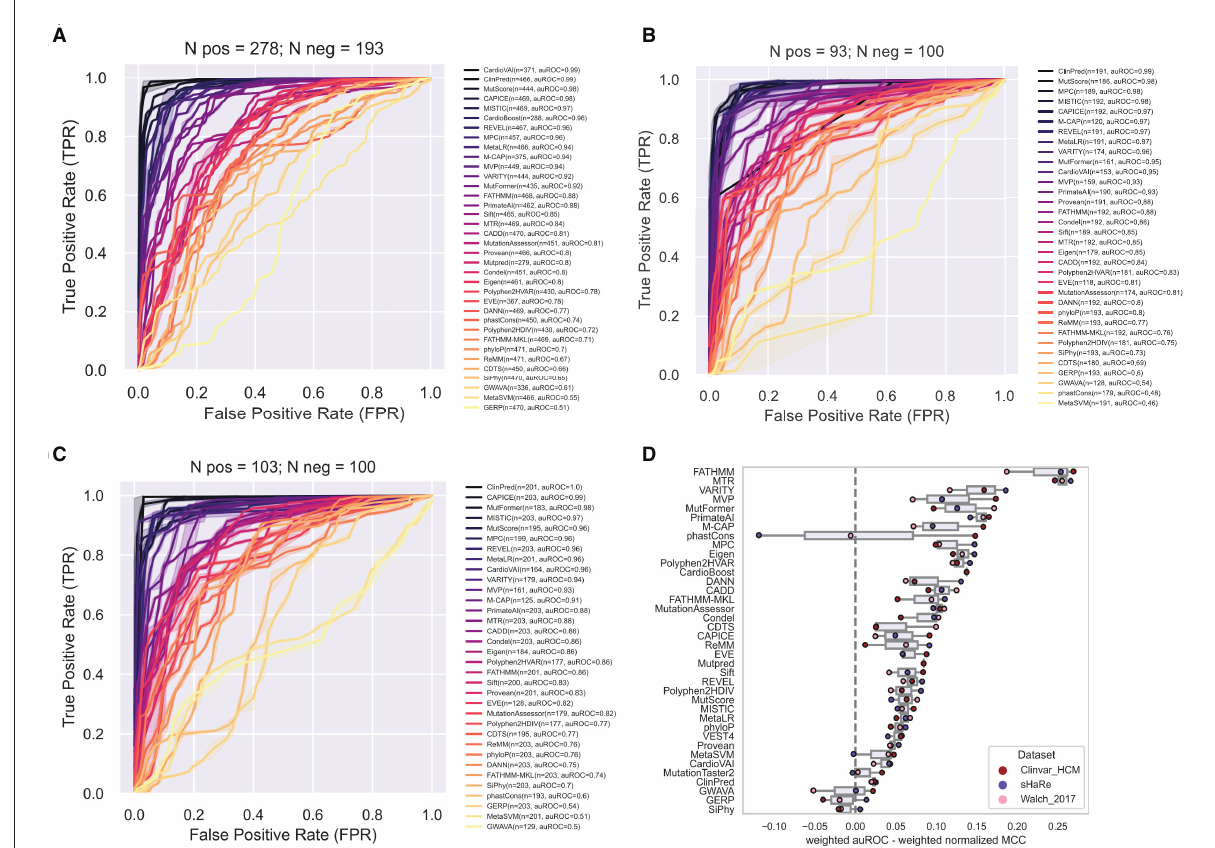
FIGURE4 Performance of prediction tools in classifying HCM missense variants using ROC curve analysis for ClinVar (A) , SHaRe (B) and Walsh_2017 (C) datasets. For each dataset, the numbers of pathogenic/likely pathogenic (N pos) and benign/likely benign (N neg) variants are indicated. Tools were ranked according to the area under the ROC curve (auROC). The number (n) of variants predicted by each tool is indicated. Tools with more than 50% of missing predictions were not included. (D) Differences in the metrics when evaluating with auROC and weighted normalized MCC. For comparison, auROC values were weighted by the fraction of variants predicted by each